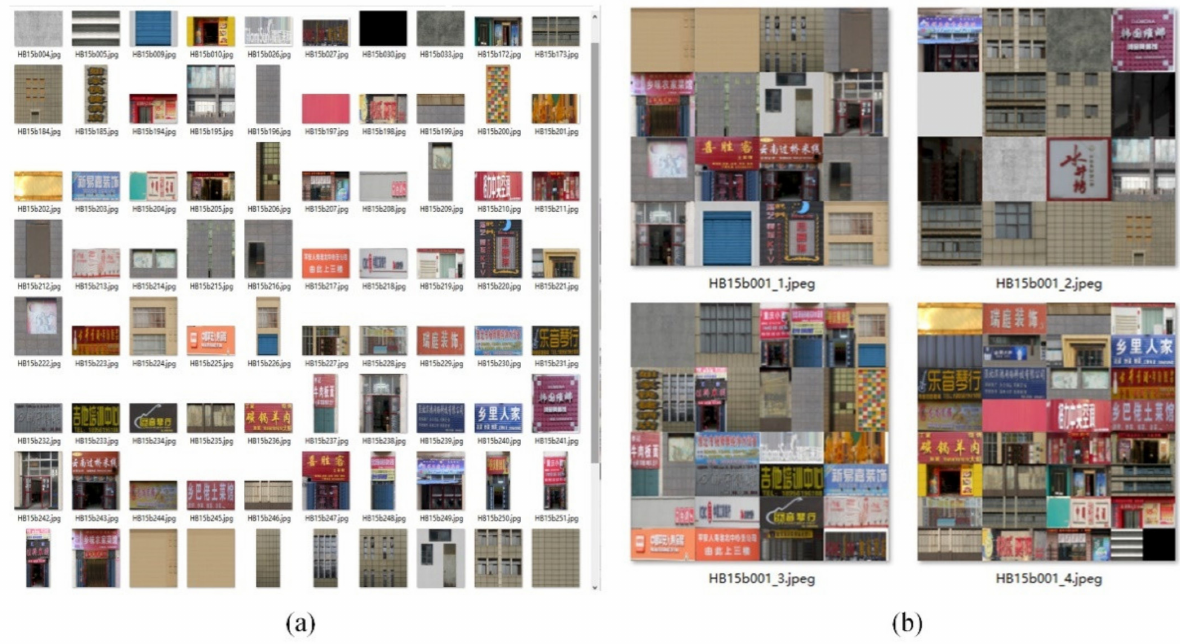
Figure 9. Texture mapping: ( a ) original texture and ( b ) texture atlas.